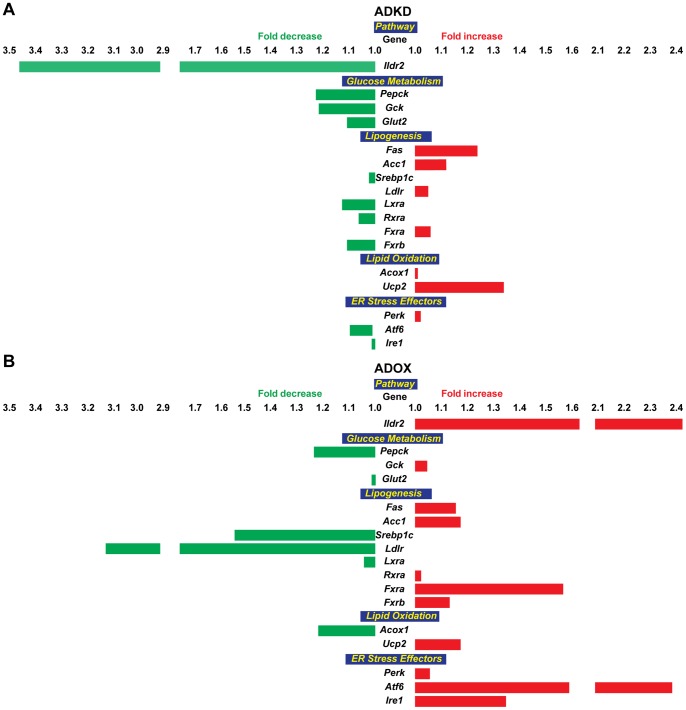
Relative expression of selected genes in ADKD and ADOX primary hepatocytes.To identify short-term effects of changes in Ildr2 expression, hepatocytes from five 10-week-old B6 mice were extracted, pooled and plated into individual wells and exposed, in triplicate, for 24 hr to ADOX or ADKD viral vectors. RNA was extracted, transcribed into cDNA, and expression was determined by qPCR. (A) Expression in hepatocytes transduced with adenovirus knockdown vector expressing RNAi for lacZ or Ildr2; (B) Expression in hepatocytes transduced with adenovirus vector over-expressing GFP or Ildr2. These results recapitulate those seen the in vivo studies.